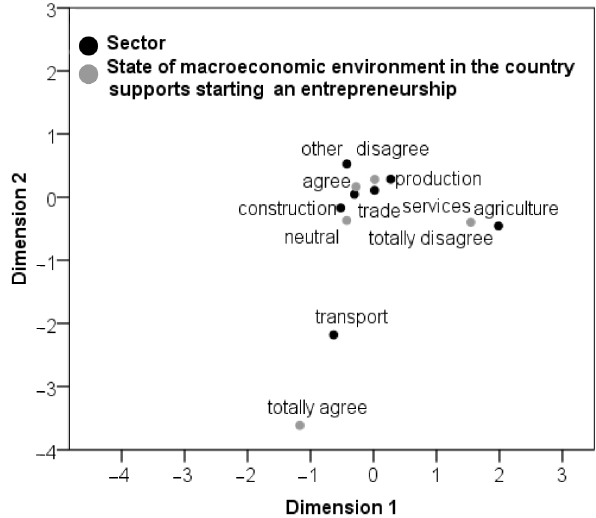
Figure 7. Correspondence analysis/the Slovak